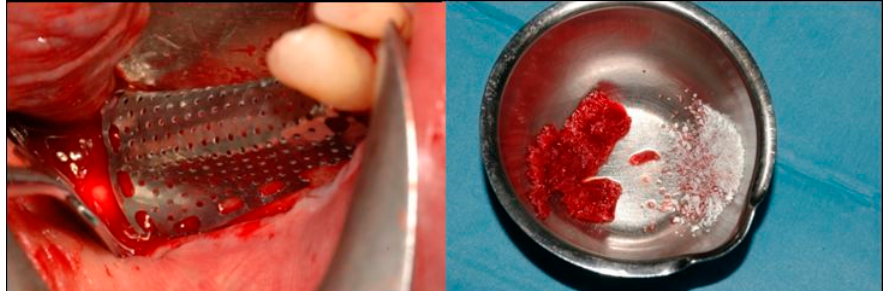
Figure 6. ( Left ) The fit of the preshaped mesh was checked, and ( Right ) the autogenous bone was mixed with the xenograft.